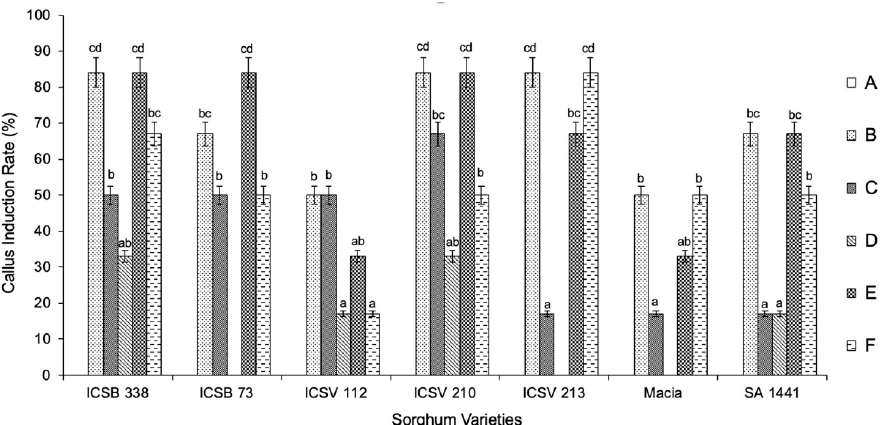
Table 1. List of primer sequences of sorghum genes used in quantitative real ‐ time polymerase chain reaction (qRT ‐ PCR)